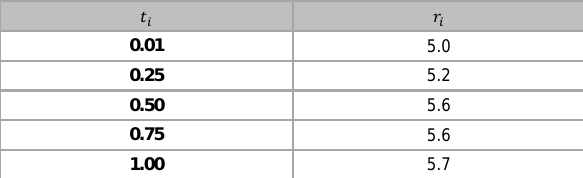
Example illustrating the implications of a discontinuous forward